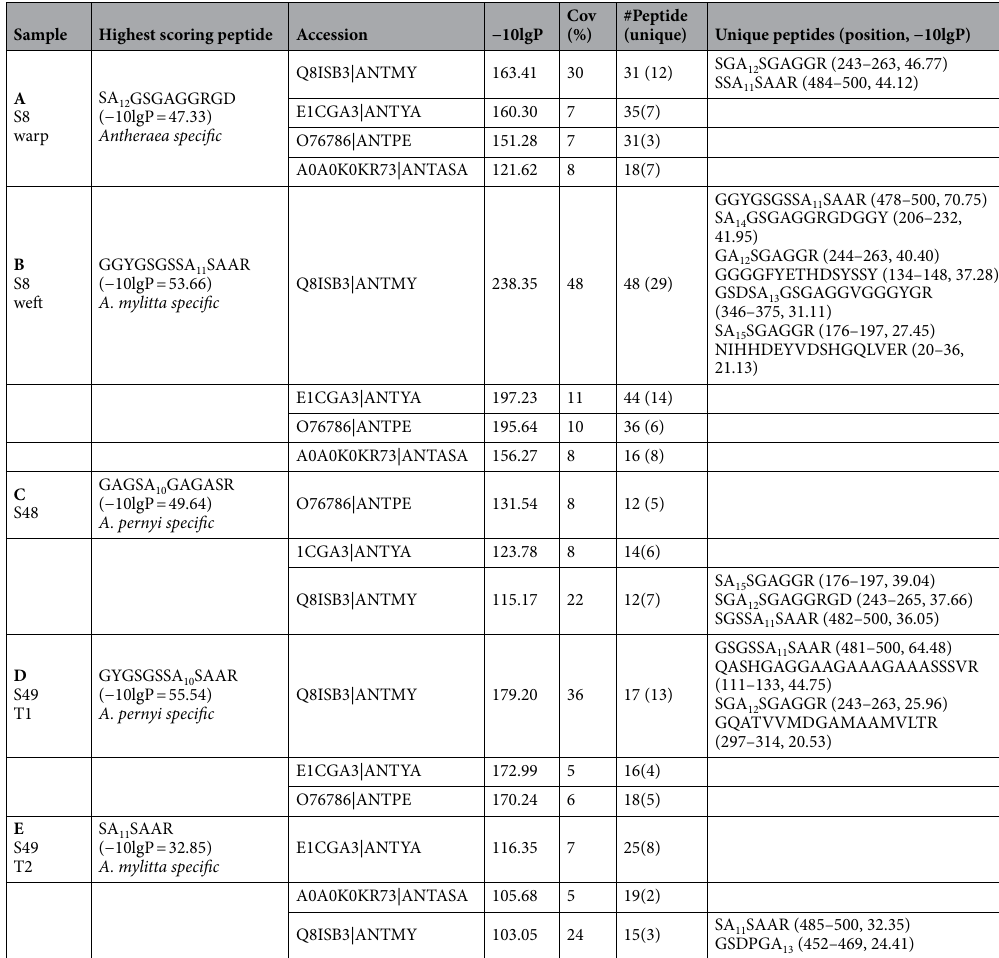
Table 2. Summary of the de novo homology matching performed on the results from the proteomic analysis of the Palmyra samples. Accession codes are in the format of UniProtKB. The −10lgP score indicates the statistical significance of the peptide-spectrum match. Peptides were filtered by −10lgP values ≥ 20, and the values ≥ 70 is usually considered significant for